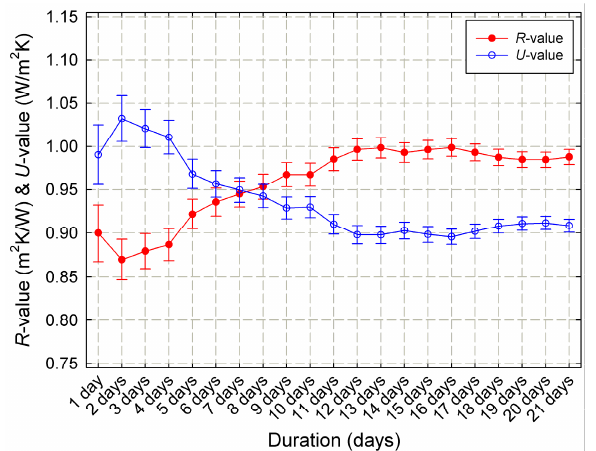
Figure 3. Evolution of in situ R -value and U -value with their expanded uncertainties.